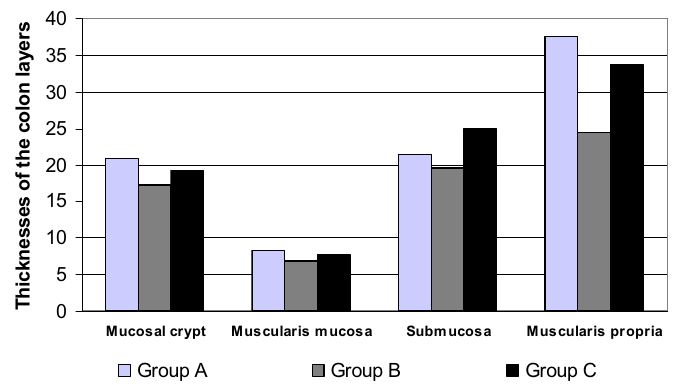
FIGURE 8 – Variance of the thicknesses of all colon lawyers, in the segments with and without intestinal transit in the different experimental groups. Data is present as mean of micrometers. One way analysis of variance (ANOVA) + Newman-Keuls test: p< 0.05 for mucosal crypt; p< 0.01 for muscularis mucosa (Group A x Group B); p< 0.05 for submucosa (Groups A and B x Group C); p< 0.01 for muscularis propria (Group A x Group B and Group B x Group C).